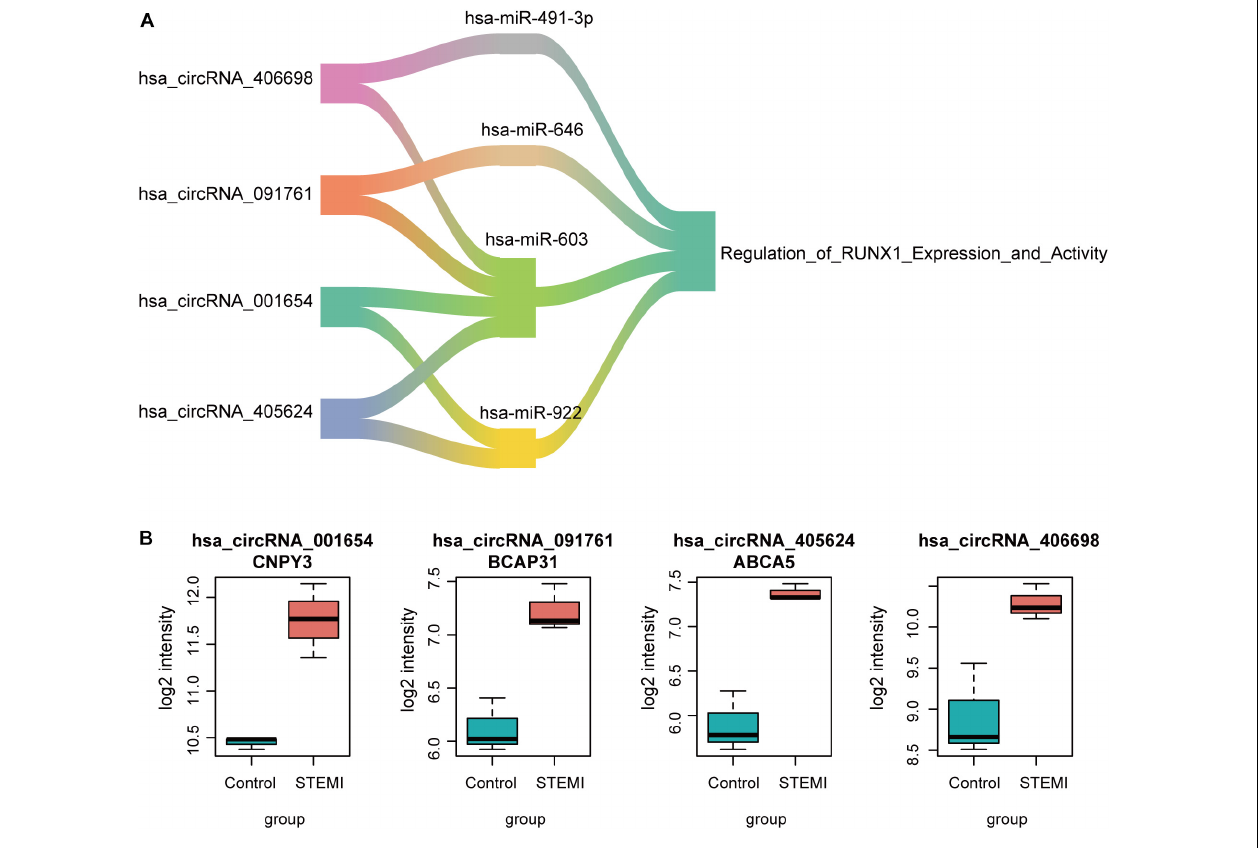
Frontiers in Genetics |